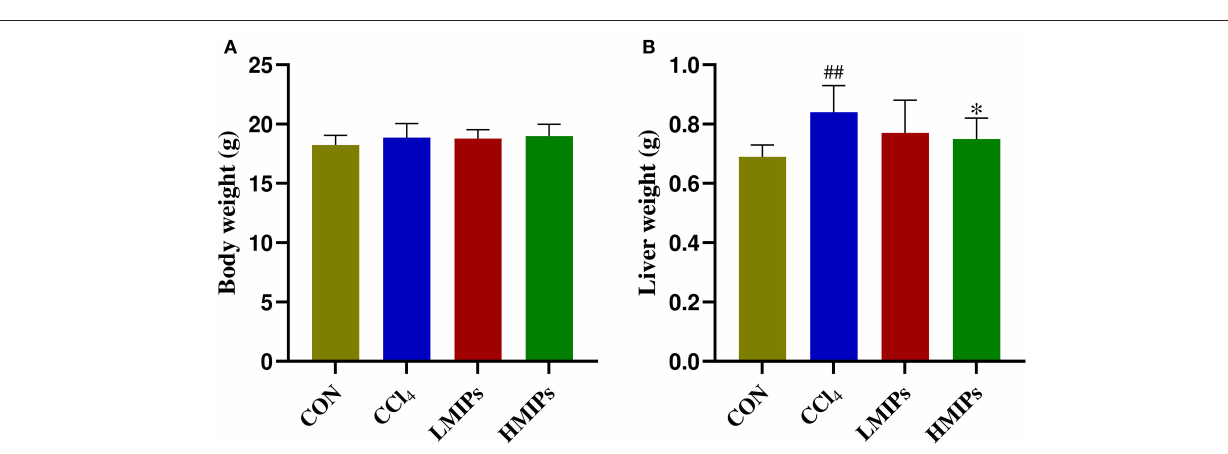
Frontiers in Physiology |